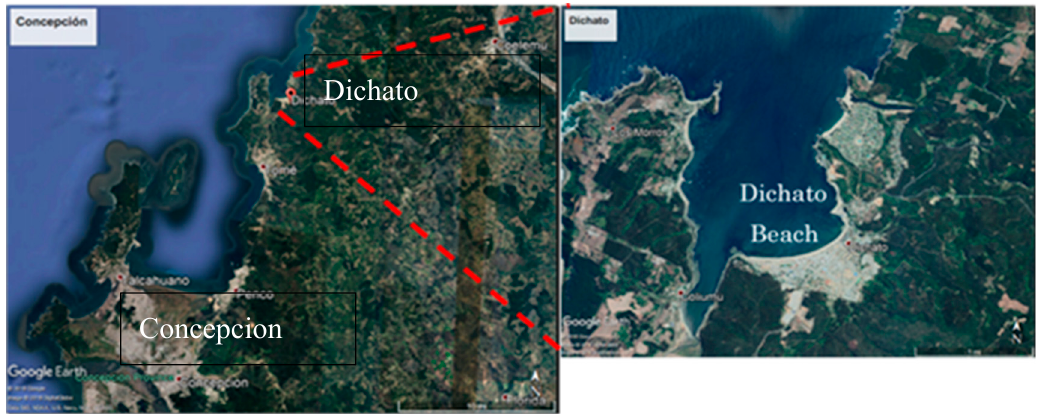
Table 1. Comparison of study sites. Disaster Information